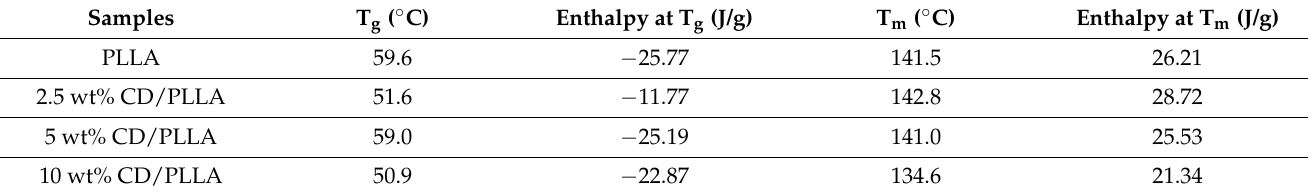
Figure 6. DSC thermograms of PLLA and CD/PLLA nanofibers.